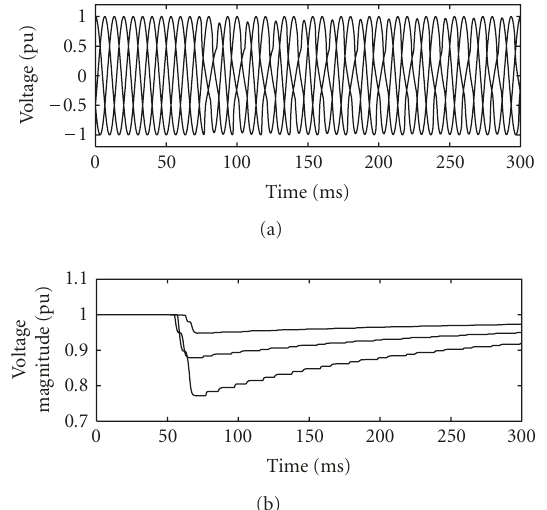
Figure 5: Voltage dip due to transformer energizing: (a) voltage waveforms; (b) voltage magnitude (EMTP simulation).